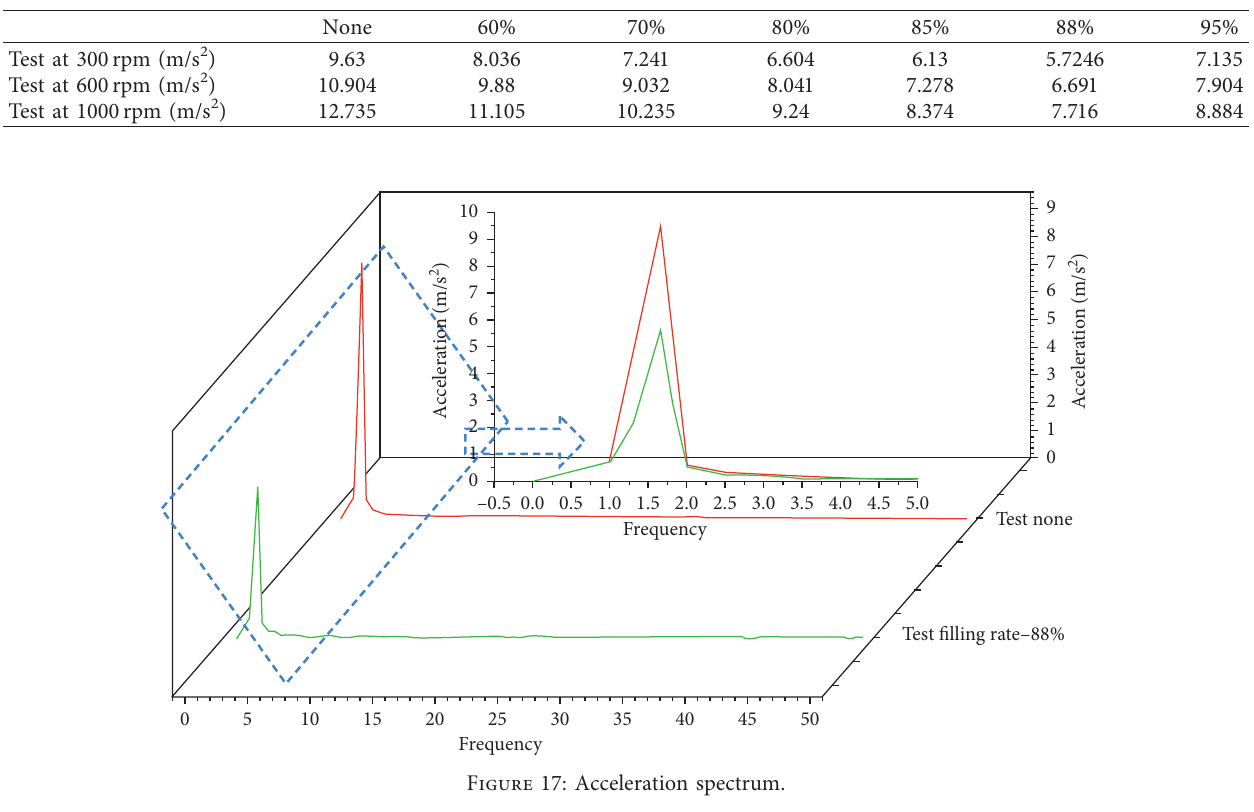
Figure 17: Acceleration spectrum.